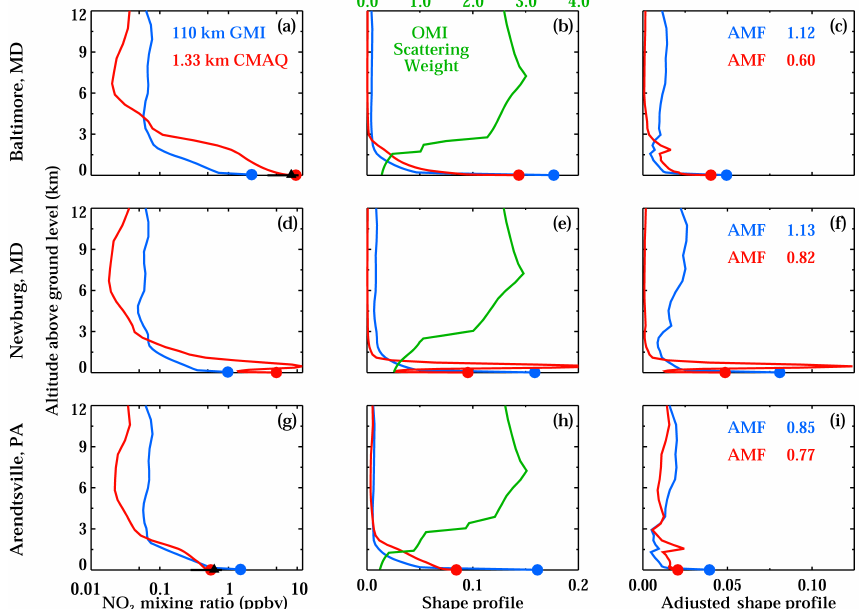
Figure 2. ( a , d , g ) Mean 14:00 LT June and July 2011 NO 2 mixing ratio as a function of altitude from a GMI (1 . 25 ◦ × 1 ◦ ; ∼ 110km × 110km) model simulation and CMAQ (1 . 33km × 1 . 33km) model simulation for three locations: (a) downtown Baltimore, (d) Morgantown power plant in Newburg, MD, and (g) Arendtsville in rural Pennsylvania. Black triangles with error bars as discussed in the text represent co-located surface observations from the EPA monitoring network. ( b , e , h ) NO 2 shape profiles (partial NO 2 columns divided by total NO 2 column) as function of altitude for the same time frame and locations; green line denotes co-located OMI scattering weight. ( c , f and i ) “Adjusted” shape profiles, partial NO 2 columns divided by total NO 2 columns multiplied by OMI scattering weight, as function of altitude for the same time frame and